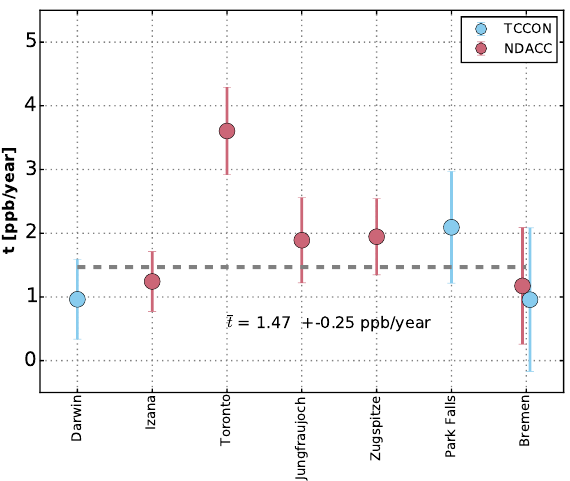
Figure 9. Linear bias trend t of the mean bias (SCIAMACHY–FTS) derived from 30-day median values shown in Figs. 6 and 7. Stations with a low retrieval noise that cover the full mission period were selected. Trends are given per station in ppb/year and error bars are the standard deviation. The ˆ t is the average of the bias trends weighted by the errors excluding measurements at